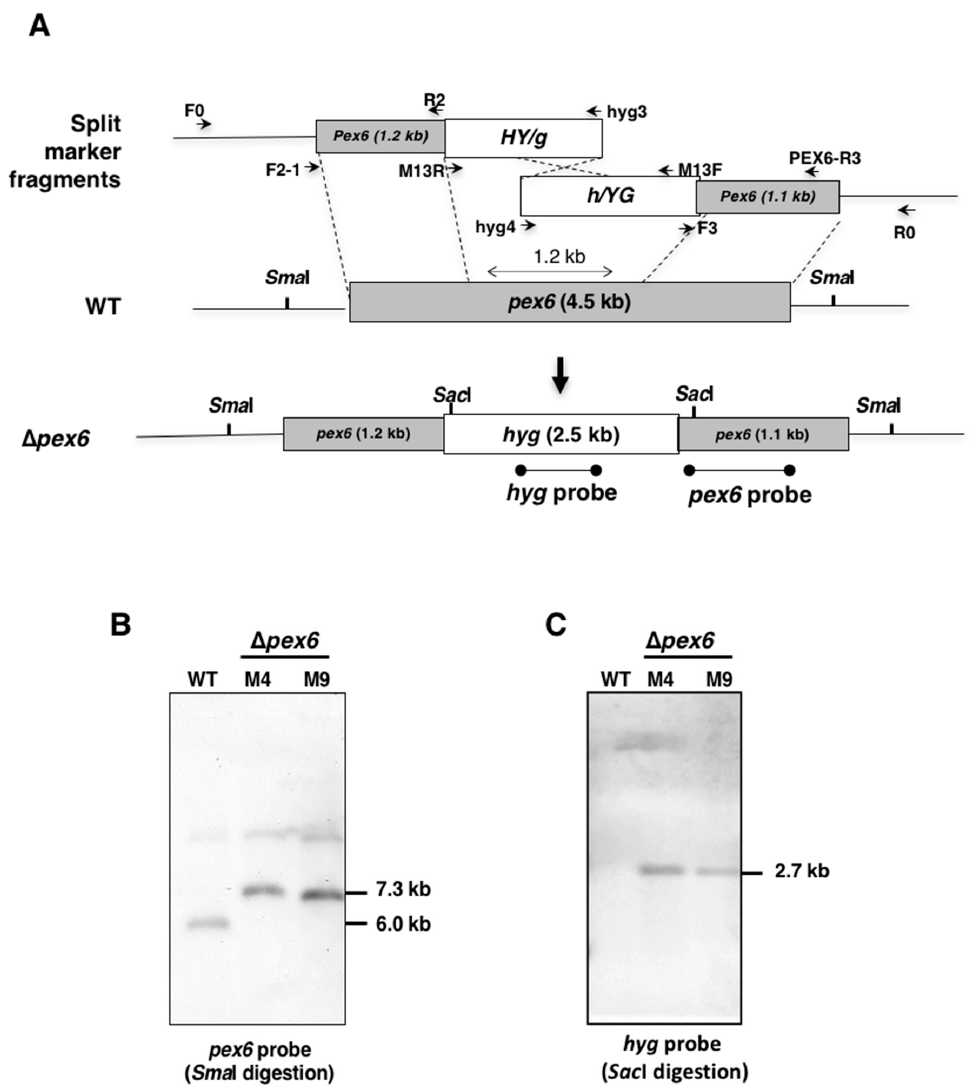
Figure 1. Deletion of a peroxin 6-coding gene ( pex6 ) using a split marker approach in the tangerine pathotype of A. alternata . ( A ) Schematic depiction of gene disruption of pex6 via a homologous recombination using truncated but overlapping DNA fragments of a hygromycin phosphotransferase-coding gene ( hyg ) under control by the Aspergillus nidulans trpC promoter and terminator. Split marker fragments, 5’pex6::5’HY/g fragment and 3’pex6::3’h/YG fusion fragment, were amplified with primers F2-1 pairing with hyg3 and PEX-R3 pairing with hyg4, respectively. Oligonucleotide primers used to amplify each fragment are indicated; ( B ) Southern-blot hybridization of genomic DNA prepared from wild-type (WT) and two putative pex6 mutants ( Δ pex6 -M4 and M9), in which a 1.2-kb region of pex6 ORF was replaced with a hyg cassette. Fungal DNA was cleaved with Sma I endonuclease, electrophoresed, blotted to a nylon membrane, and hybridized with a pex6 probe. A faint band (estimated > 10 kb), likely due to incomplete digestion, was detected in all three samples; ( C ) Southern-blot hybridization of genomic DNA digested with Sac I and hybridized with a hyg probe.